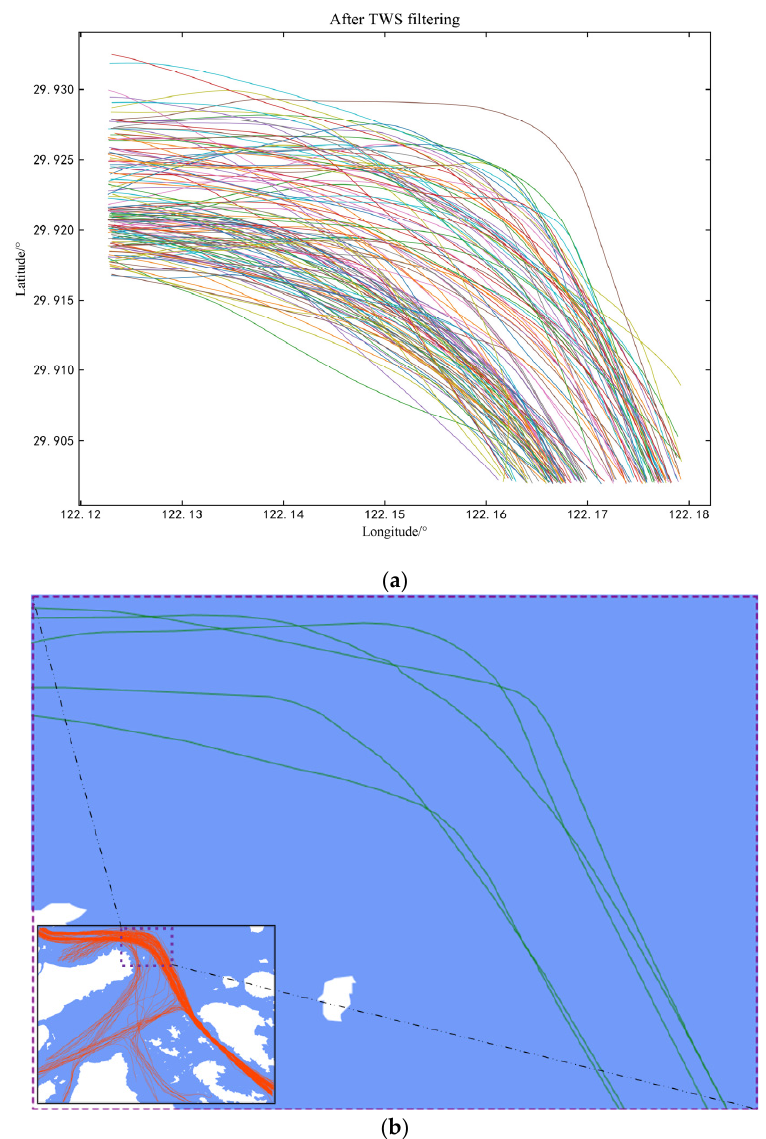
Figure 4. Trajectory after time window panning and smoothing fi ltering: ( a ) Vessel trajectory in the geographical area after fi ltering ( b )The mapping of part of the anomalous trajectory after geographical area after filtering ( b ) The mapping of part of the anomalous trajectory after smoothing.